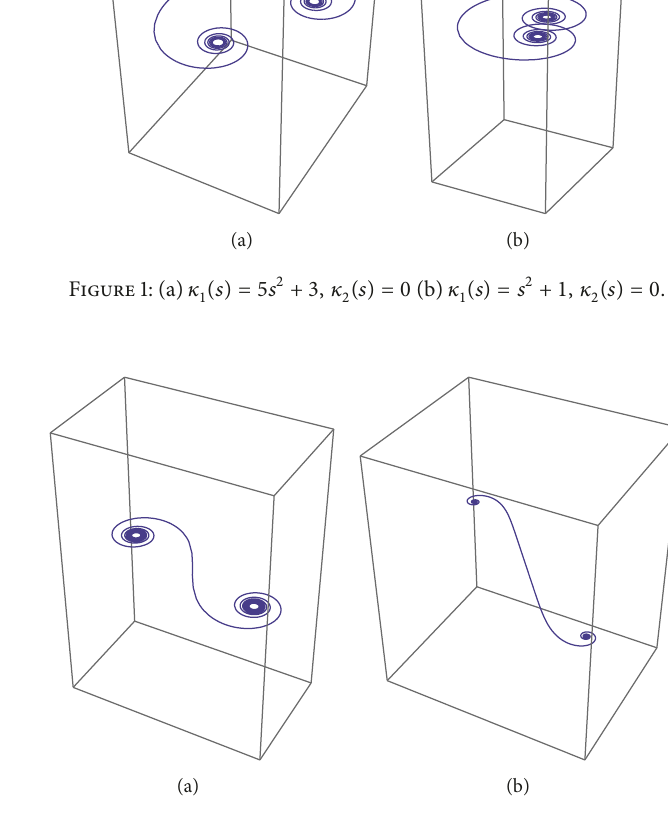
Figure 2: (a) 𝜅 1 (𝑠) = 5𝑠 , 𝜅 2 (𝑠) = 0 , (b) 𝜅 1 (𝑠) = 5𝑠 5 , 𝜅 2 (𝑠) = 0